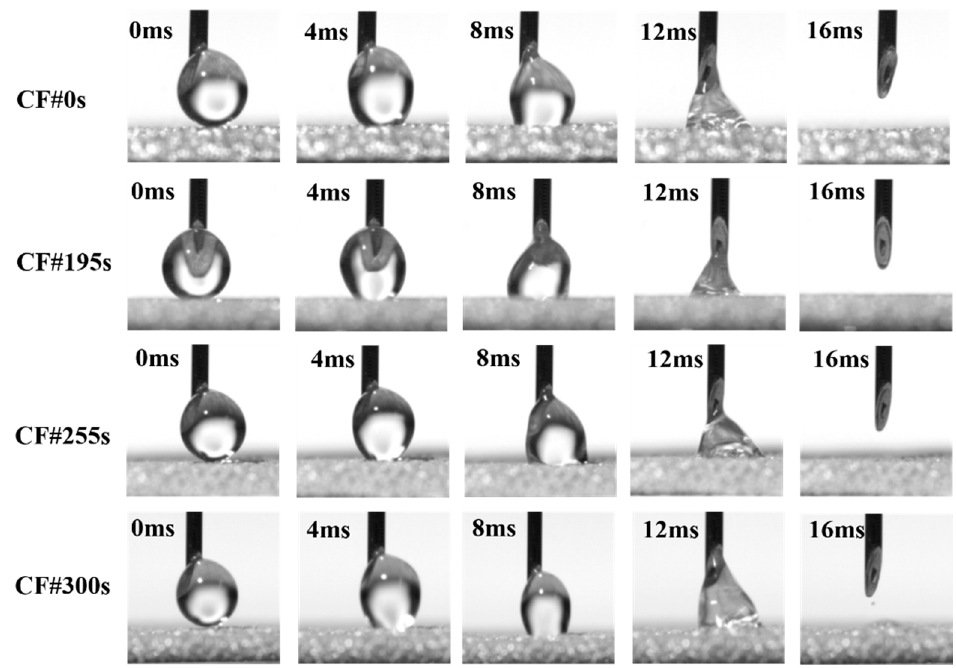
Figure 8. Wettability measurement for different samples using a 4- μ L water droplet.